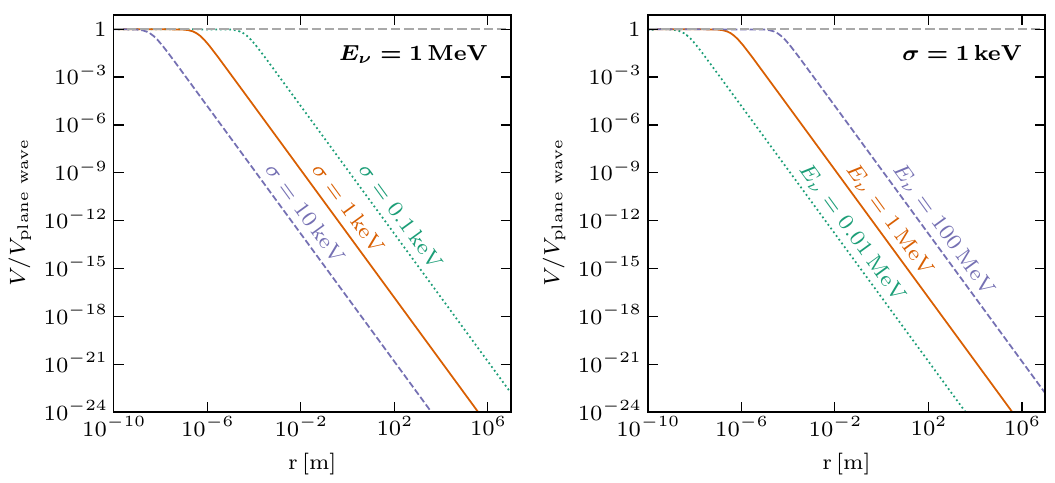
Figure 3. Suppression of the background-induced 2- ν -mediated potential between two fermions due to the inclusion of a finite width packet of the background states as a function of the distance between the fermions. The figures illustrate the dependence of the effect on the neutrino energy and the width of the